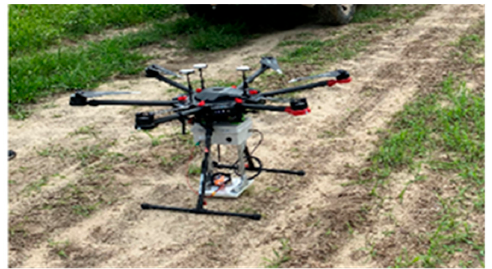
Figure 1. Radio Frequency Identification (RFID) reader and DJI Matrice 600 Pro.